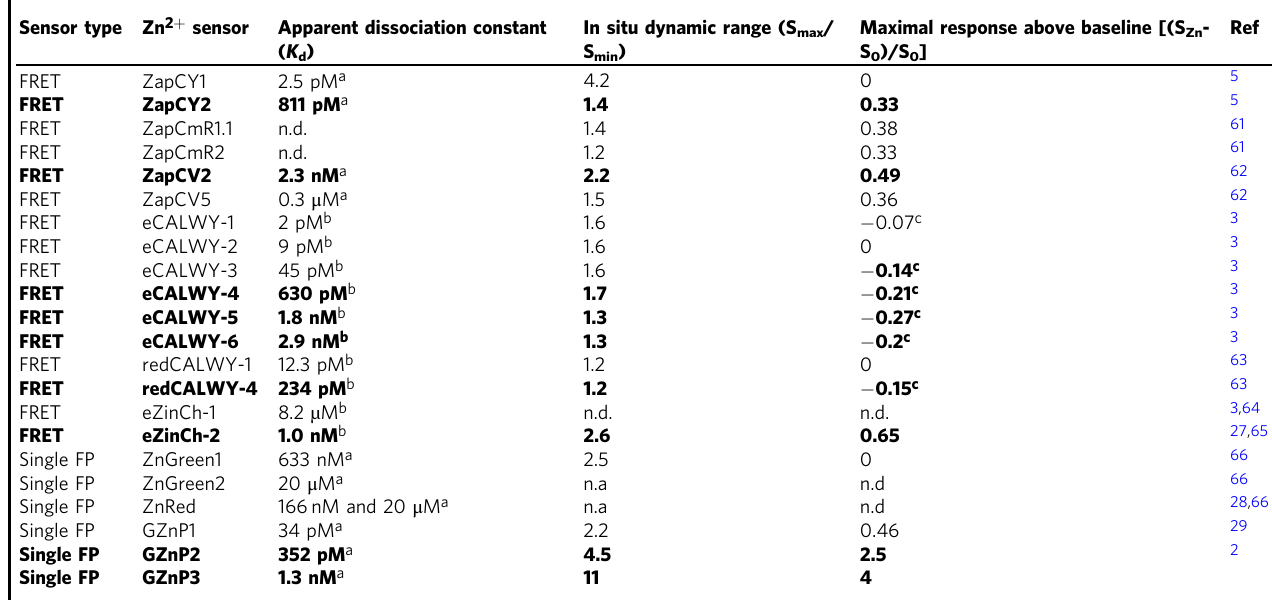
Boldsensorsshow potentialdetectionsensitivitybetween100pM and1nM.FRETsensorsweremeasuredusingratioof acceptortodonor emission( Δ R/R 0 )and singleFPsensorsweremeasuredusing single emission ( Δ F/F 0 )